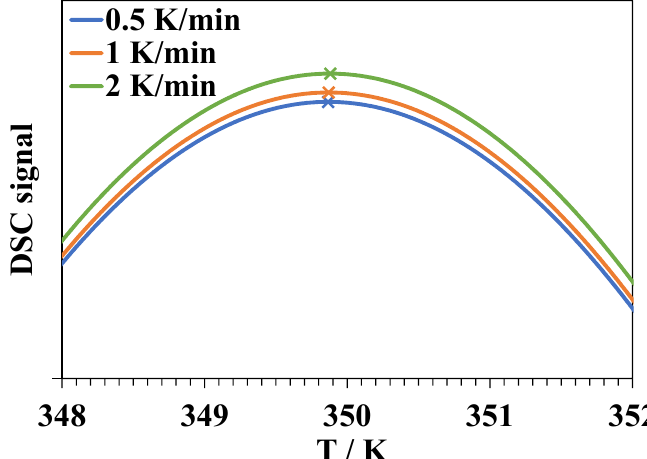
Figure 6. The results of the numerical simulation of the DSC curves at heating rates of 0.5, 1, and 2 K · min − 1 for a hypothetical reversible single-step denaturation process in pure water.